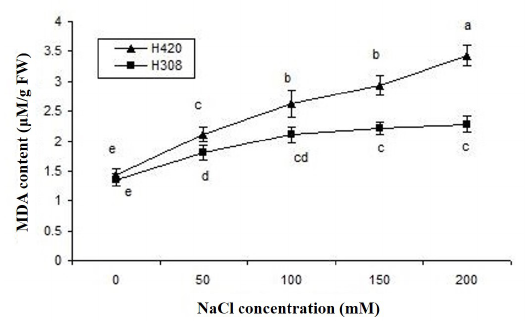
Fig. 2. The effect of various salt concentrations on lipid peroxidation (MDA content) in leaves of two canola genotypes (H420 and H308). Values are mean ± SE (n=3). Means followed by the same letter did not significantly differ at P ≤0.05 according to Duncan’s multiple range